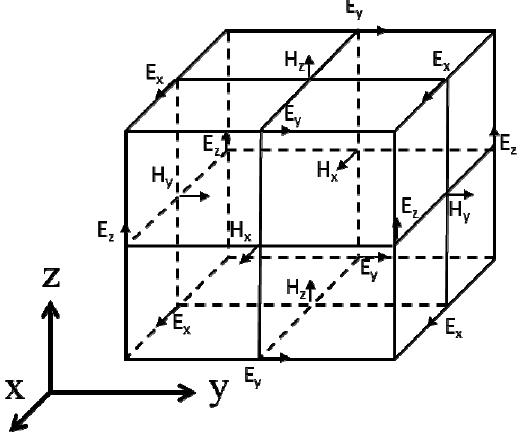
Figure 10. Yee cell. Arrows indicate the direction of the E or H field that is calculated at each